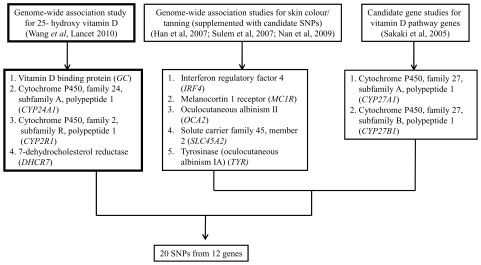
Strategy for SNP selection using genome-wide association and candidate gene studies.